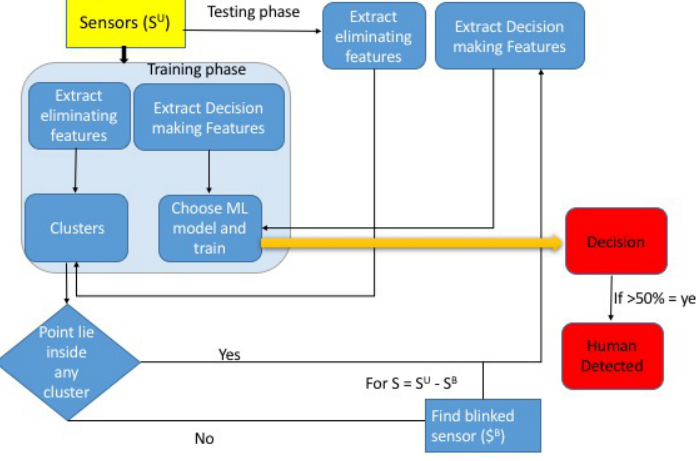
Figure 1. Overview of the system